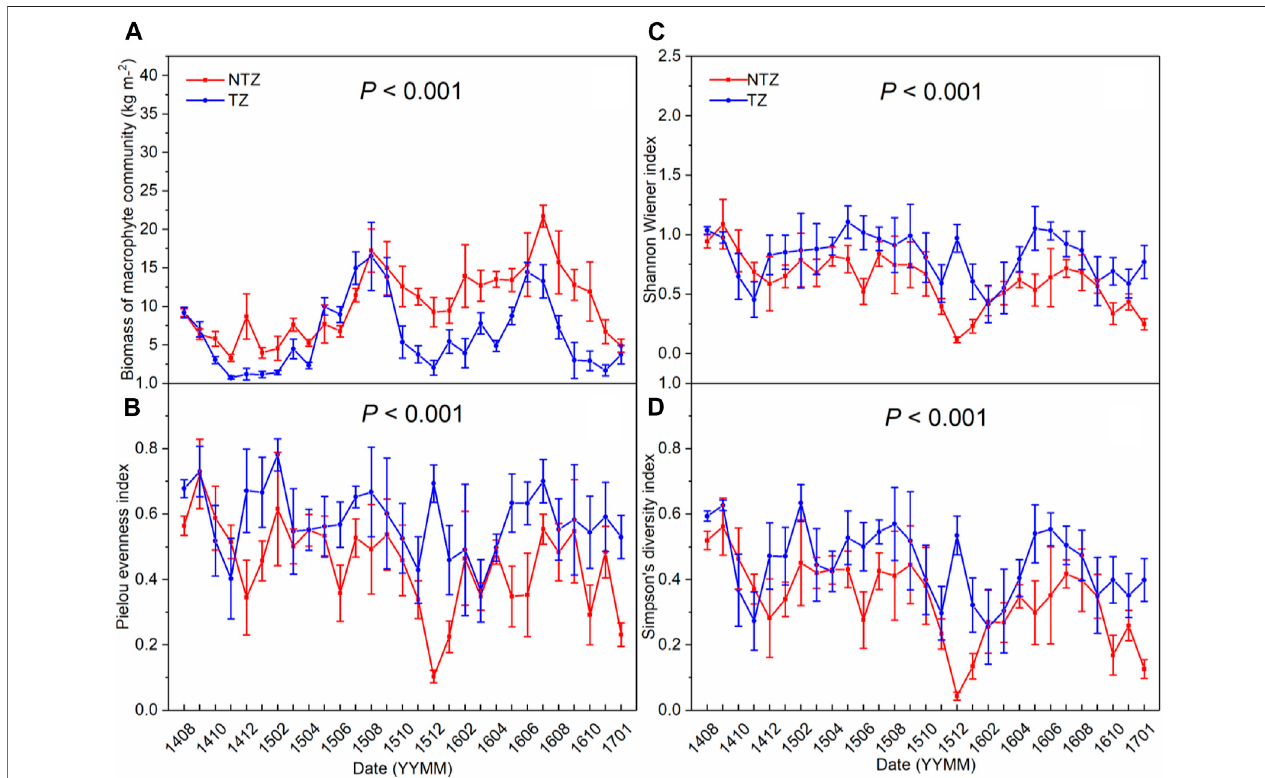
FIGURE 4 | Changing of biomass and biodiversity of macrophyte community in two zones (NTZ, non- Trapa zone; TZ, Trapa zone; number of replicates: 12). (A) biomass of macrophyte community; (B) Shannon – Weiner index; (C) Pielou ’ s evenness index; (D) Simpson ’ s diversity index.